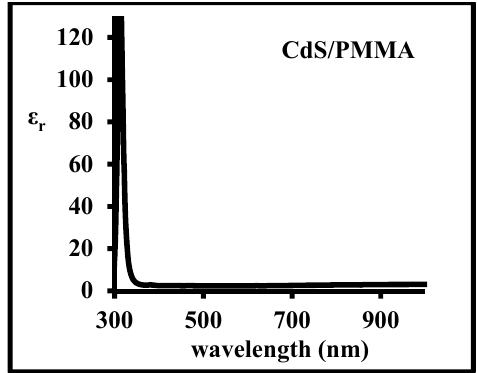
Fig. 7: The variation of the real part of the dielectric constant as a function of the wavelength for CdS/PMMA thin film.